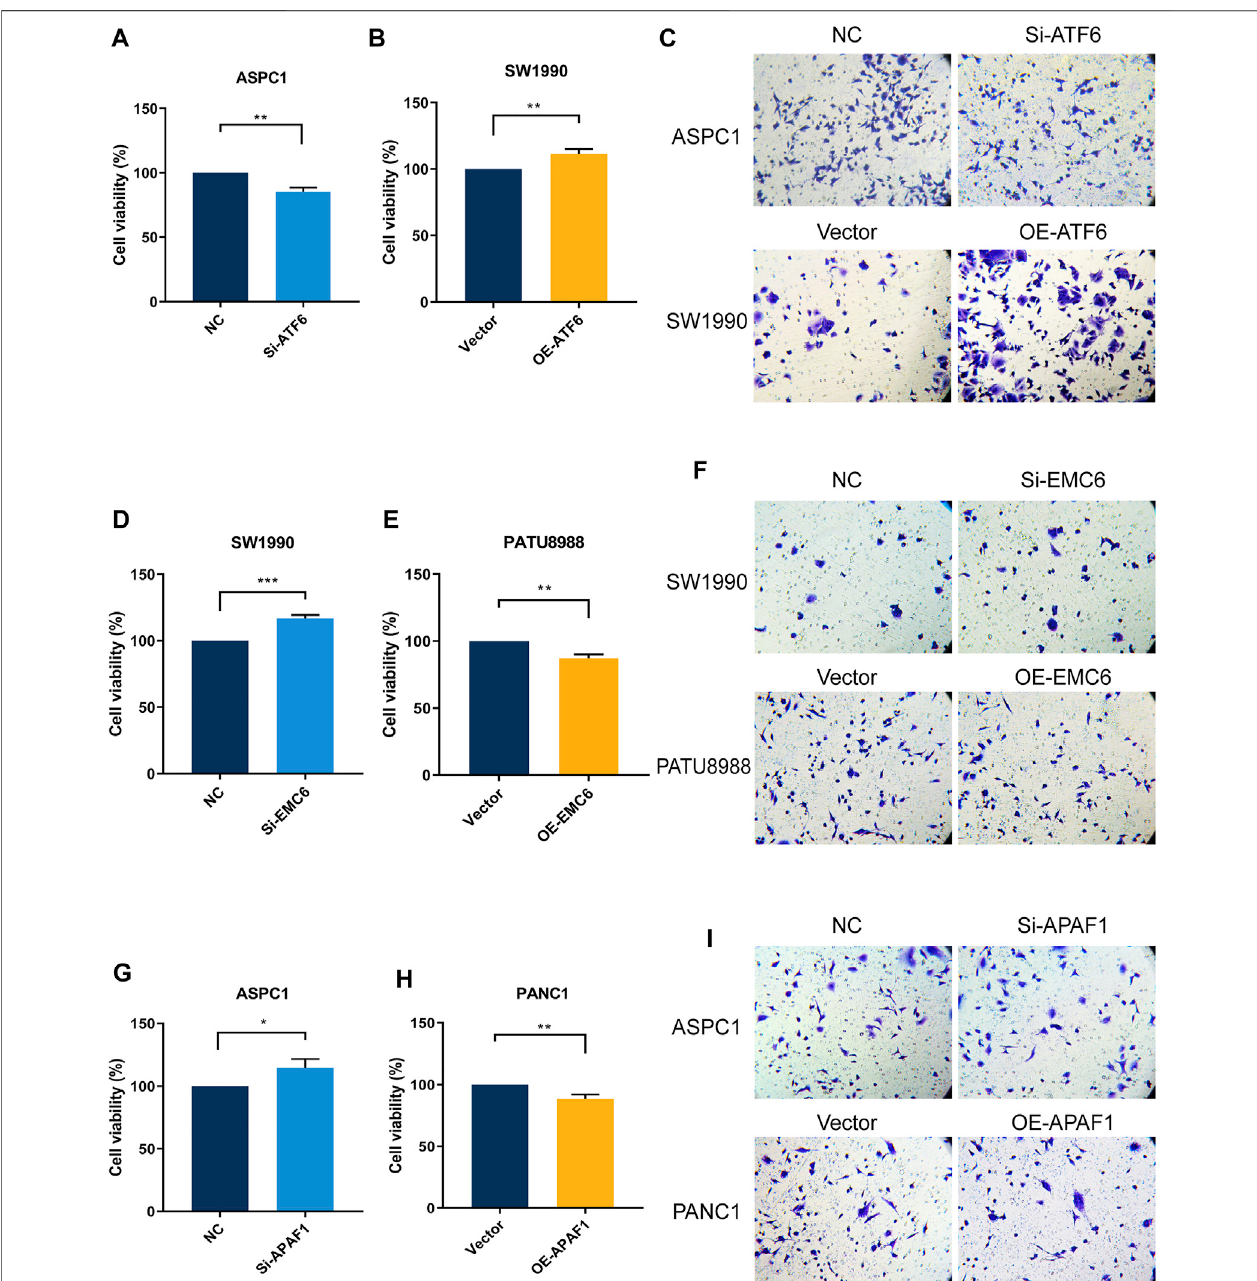
FIGURE 5 | ATF6 promoted PC cell viability and invasion, while EMC6 and APAF1 inhibited these events. ATF6 effects on cell viability and invasion of Si-ATF6 transfected ASPC1 cells and OE-ATF6 transfected SW1990 cells were determined using (A,B) Cell-counting kit-8 (CCK-8) assay and (C) Transwell assay, respectively. (D,E) CCK8 and (F) Transwell assays were, respectively, performed to measure cell viability and invasion of Si-EMC6 transfected SW1990 cells and OE-EMC6 transfected PATU-8988 cells. Cell viability and invasion of Si-APAF1 transfected ASPC1 cells and OE-APAF1 transfected PANC1 were separately evaluated using (G,H) the CCK8 assay and (I) the Transwell assay. * p ≤ 0.05, ** p ≤ 0.01, *** p ≤